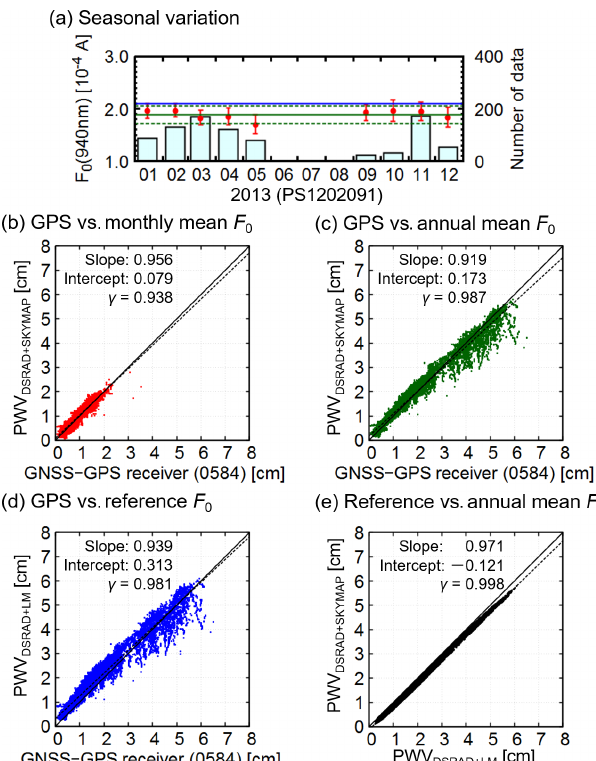
Figure 16. Similar to Fig. 15 but in